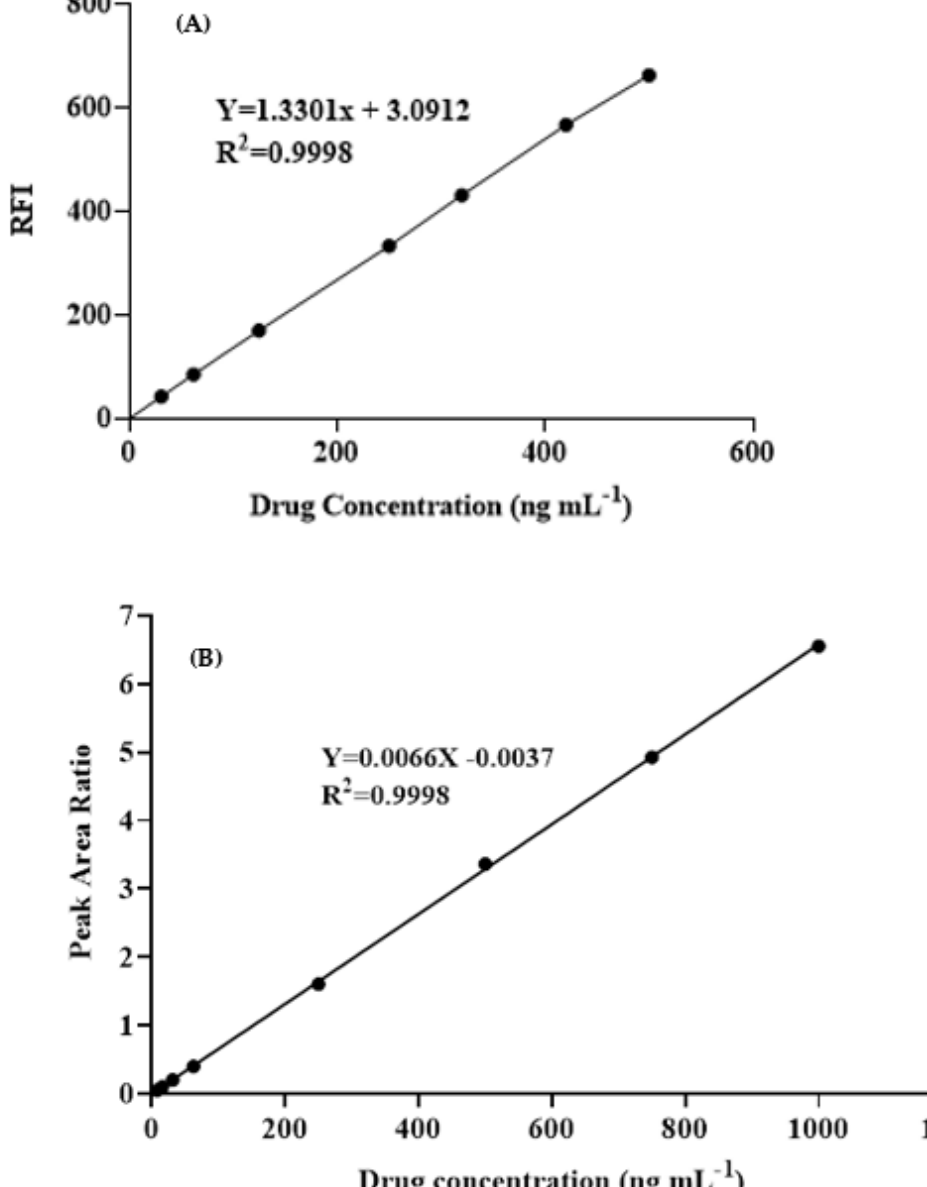
Figure 8. Standard calibration curves for the determination of ALC by the proposed MW ‐ SFL (A) and HPLC ‐ FD (B)